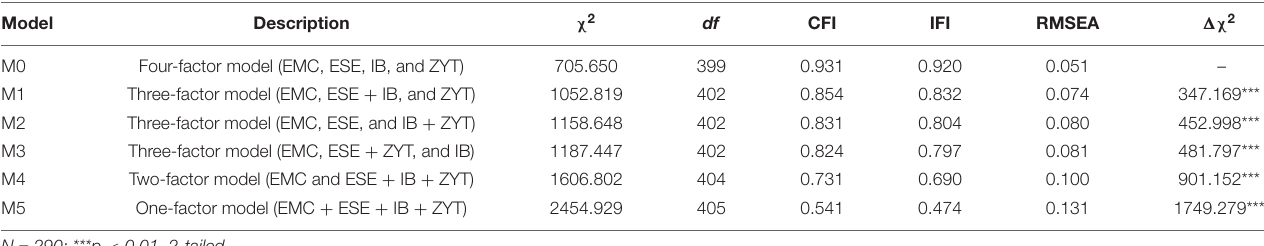
TABLE 2 | Confirmatory factor analysis by comparing alternative measurement models.